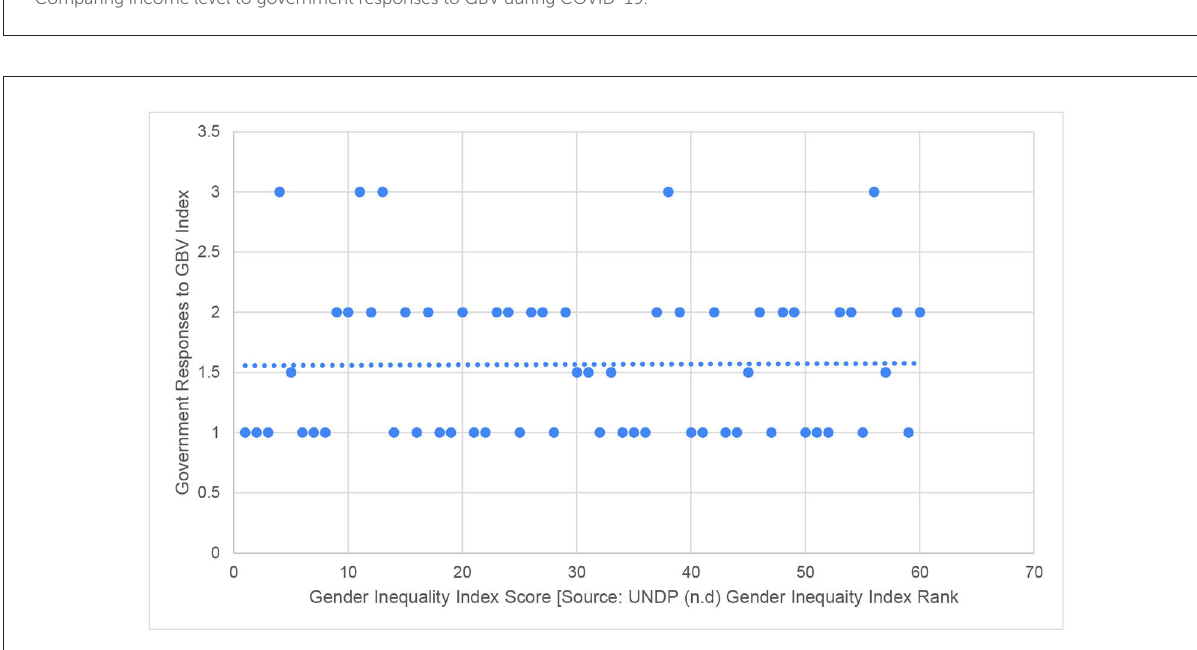
FIGURE3 Comparing gender inequality index to government responses to GBV during COVID-19.